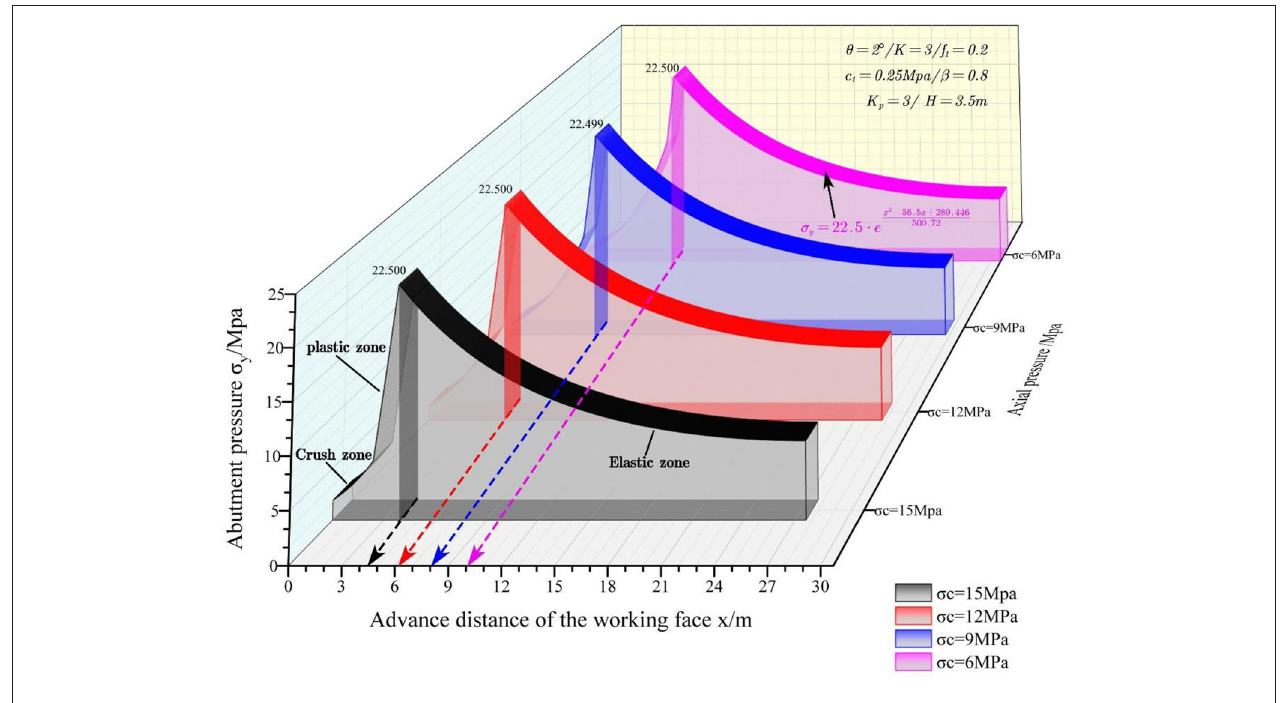
FIGURE 9 | Impacts of UCS on abutment pressure.